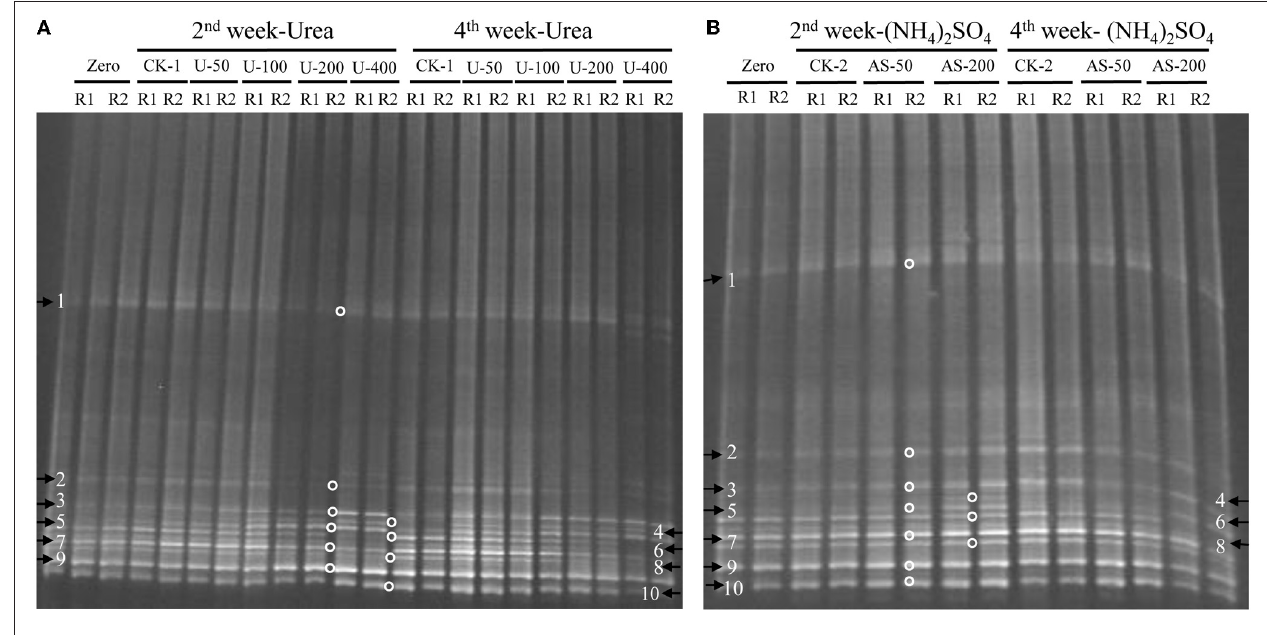
FIGURE 5 | DGGE fingerprints of the bacterial amoA gene in the soil microcosms amended with urea (A) and ammonium sulfate (B). The arrows indicate DGGE bands excised for